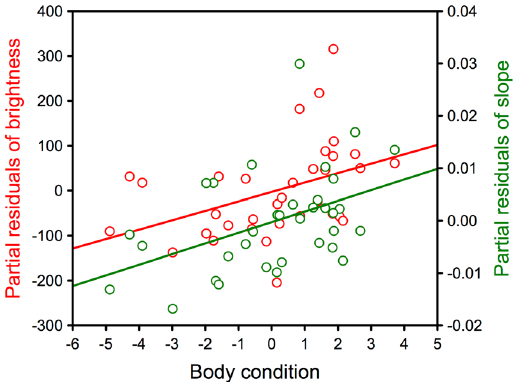
Figure 5. Relationship between the body condition of Eurasian nuthatch nestlings (residuals of body mass regressed against tarsus length) and brightness (left axis, red color) and slope (right axis, green color) of their chestnut flank feathers. The residual figures of the response variables (i.e., partial effects after applying a GLM without sex and experimental treatment in the case of brightness and without sex in the case of slope) are shown. Lower brightness and slope values indicate more intense plumage coloration and higher pheomelanin content in